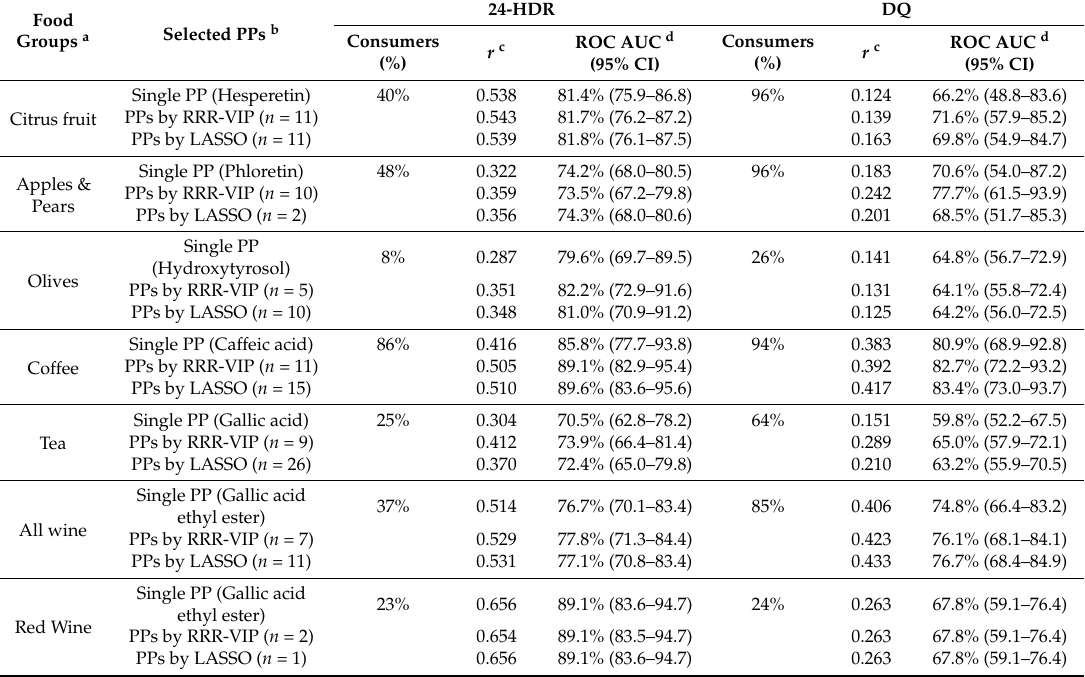
Table 4. Correlations coefficients and area under the receiver operating characteristic curves (ROC AUCs) of RRR scores of selected polyphenol (PP) metabolites with polyphenol-rich foods from 24-HDR and DQ in the test set ( n =